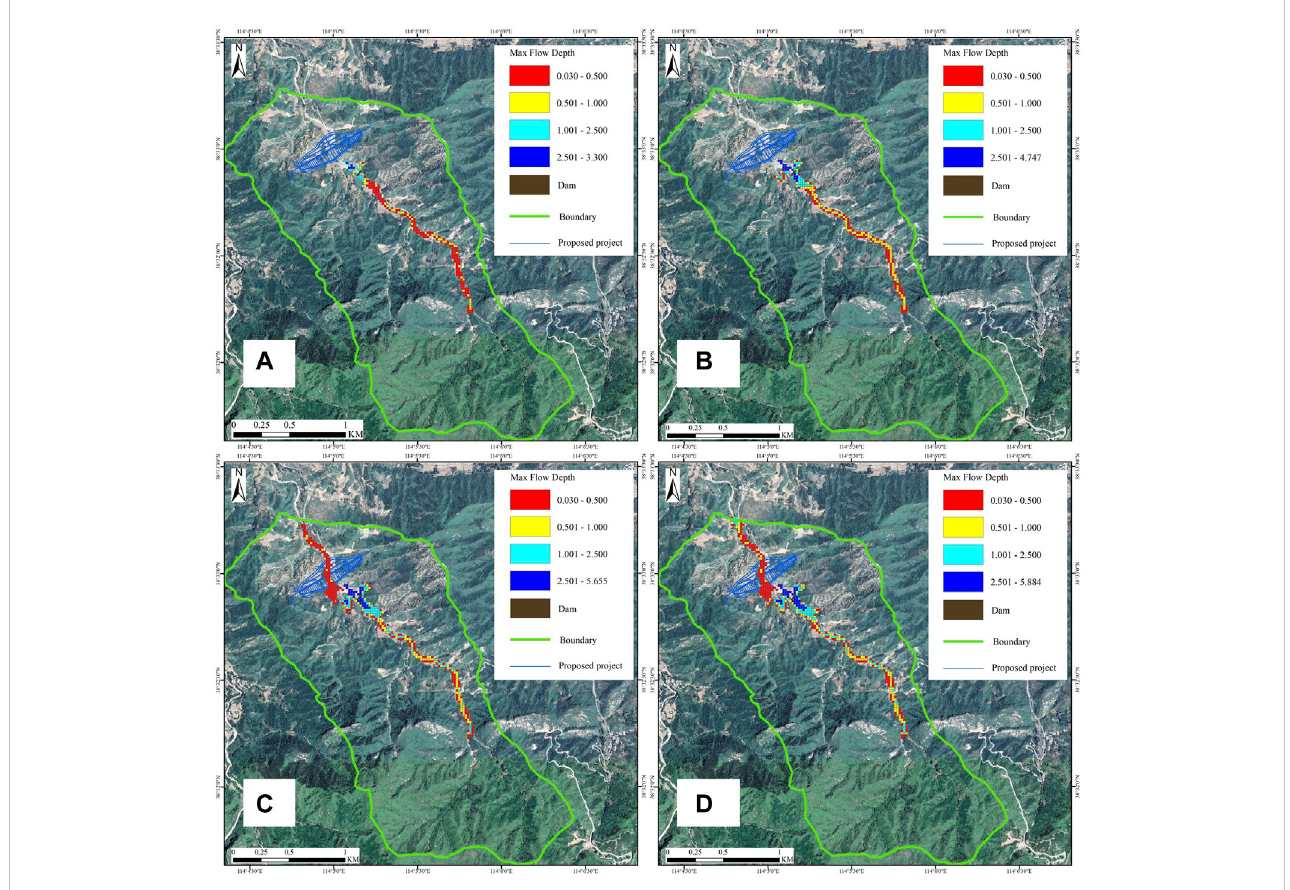
FIGURE 7 Distributionofmaximum fl owdepths(m)withretainingdamatvariousrainfallfrequencies (A) Hazardzonationwithdamunder10-yearrainfall, (B) Hazard zonation with dam under 20-year rainfall, (C) Hazard zonation with dam under 50-year rainfall, (D) Hazard zonation with dam under 100-year